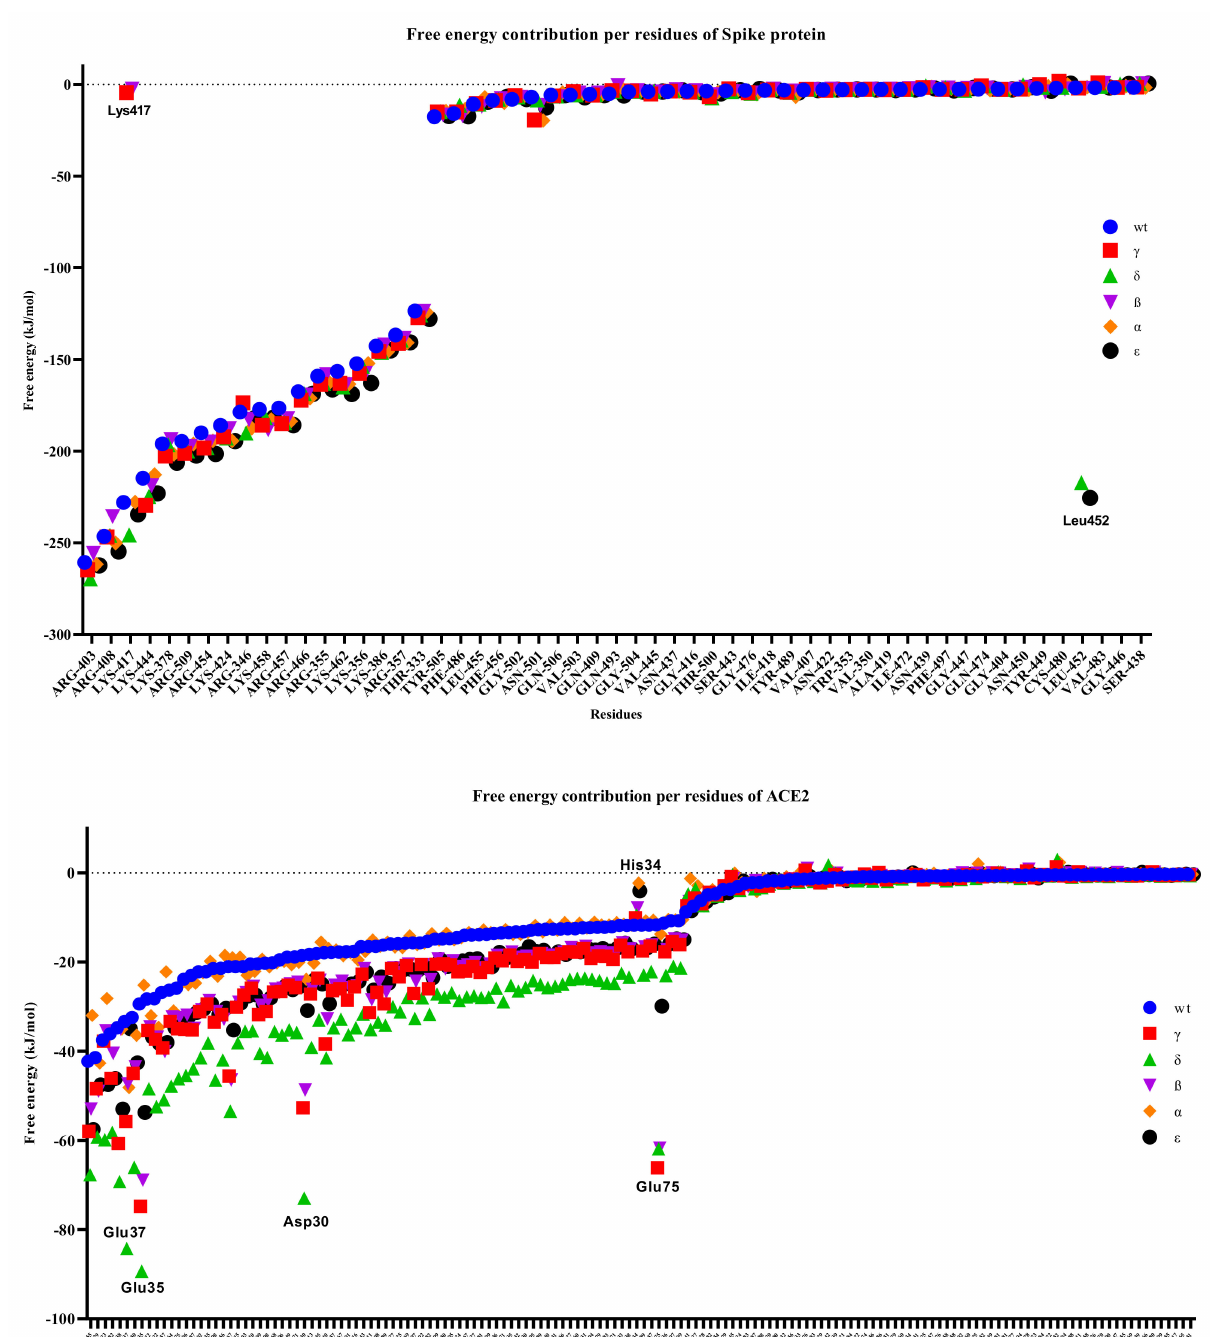
Figure 12. Free energy contributions per residue of S-hACE2 complexes throughout 100 ns MD simulation. While it was observed that Lys417, one of the S protein residues, was ineffective in the Gamma and Beta variants, we found that Leu452 in the Delta and Epsilon variants had a relatively low binding free energy of <200 kJ/mol and was largely dissociated from the other variants. In the WT RBD, Lys417 formed a salt bridge with Glu30 of RBD [31]. Salt bridges, like disulfide bonds, can act as keystone interactions